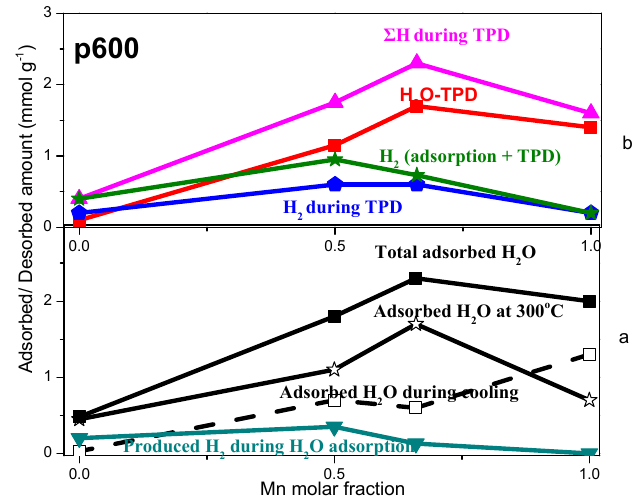
Figure 6. ( a ) Total adsorbed Η 2 Ο at 300 °C and Η 2 produced during water adsorption; and ( b ) H 2 O and H 2 desorbed during TPD from Co Α F, MnAF, CoMn11AF and CoMn12AF pyrolyzed at 600 °C.